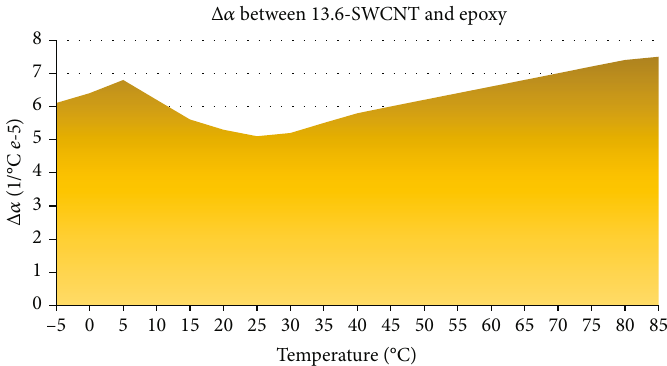
Figure 9: Mismatches between the CTEs of 13.6-SWCNT and epoxy ( Δα ) at the temperature range of -5 to 85 ° C within the 13.6-SWCNTE.